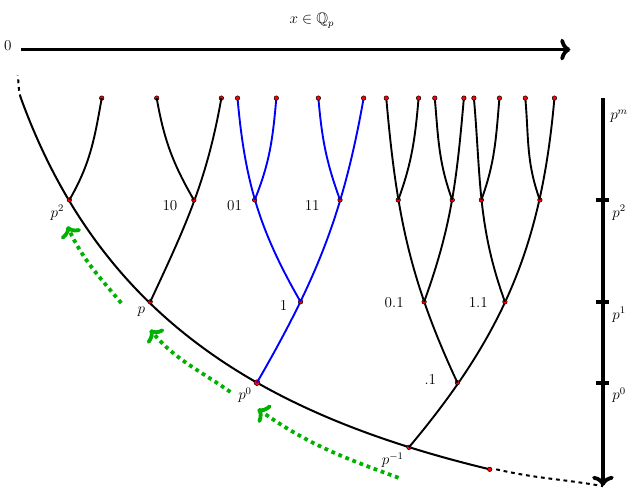
Figure 1. The 2-adic BT